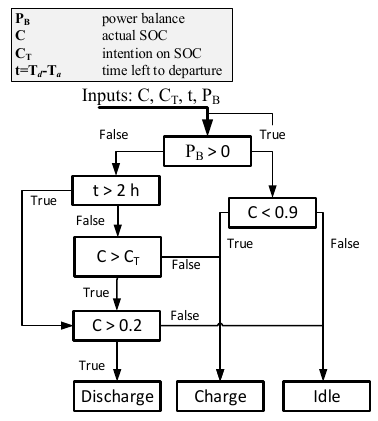
Figure 5. The state transition logic of EV operations for the prosumer.